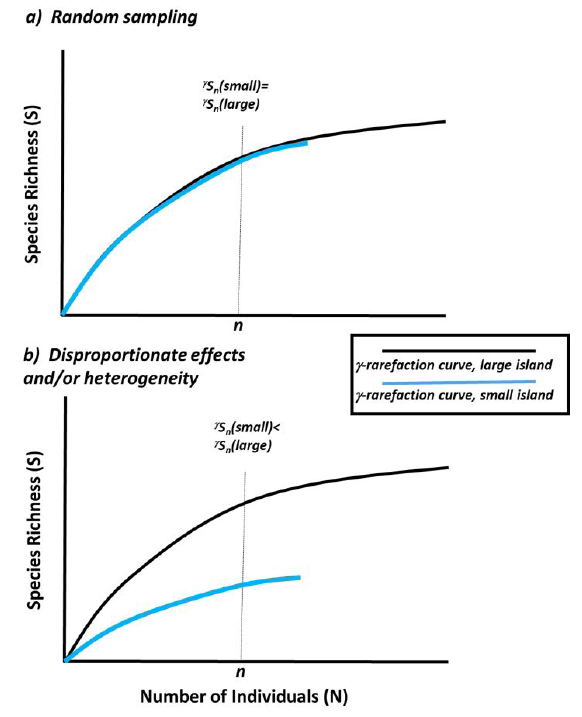
Figure 2. a) Hypothetical case where a large island has more species than a smaller island in total, but this is entirely because of random sampling (the larger island has more total individuals). Note that the rarefaction curves for each island fall on top of each other and the parameters derived from it, including γ S and γ S (not shown), are the same n PIE between larger and smaller islands. b) Hypothetical case where a large island has more species than a smaller island, and this results because both a sampling effect (the larger island has more N and goes farther down the x-axis) and a disproportionate effect (whereby γ S is lower on the smaller n than the larger island). γ S in this case (not illustrated) is PIE also smaller on the smaller island (because it has a shallower slope), but this need not be the case if only rarer species are